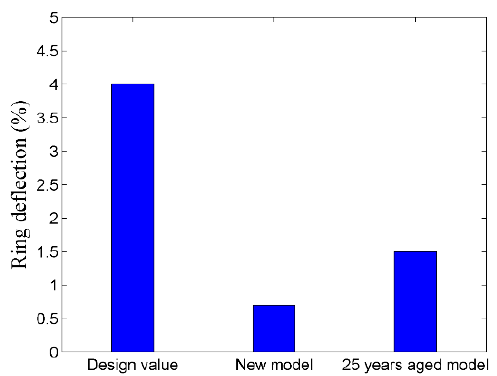
Figure 11. Percentage ring deflection comparison for the proposed scheme regarding new and aged models.